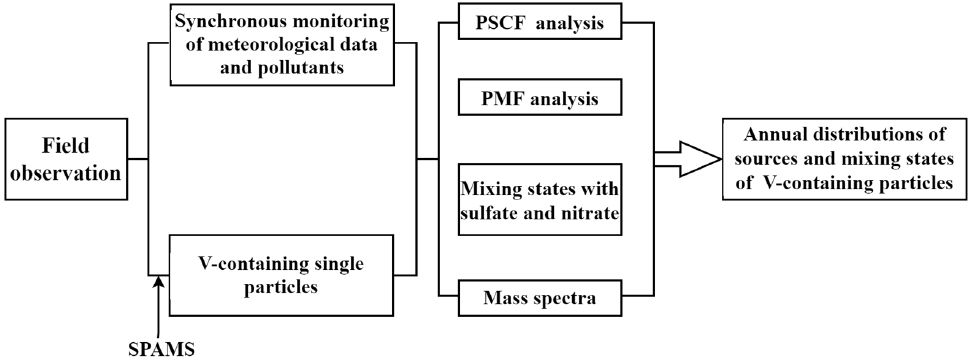
Figure 1. The fl ow chart of sampling and analytical methods. Figure 1. The flow chart of sampling and analytical